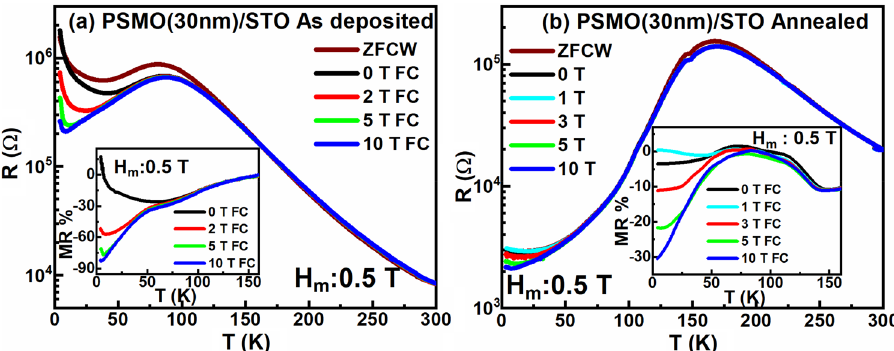
Figure 9. Cooling and heating under unequal field measurement protocol of PSMO(30 nm)/STO film for H m = 0.5 T ( a ) before and ( b ) after ex-situ annealing. The insets show the MR% of the kinetically arrested FM phase in the